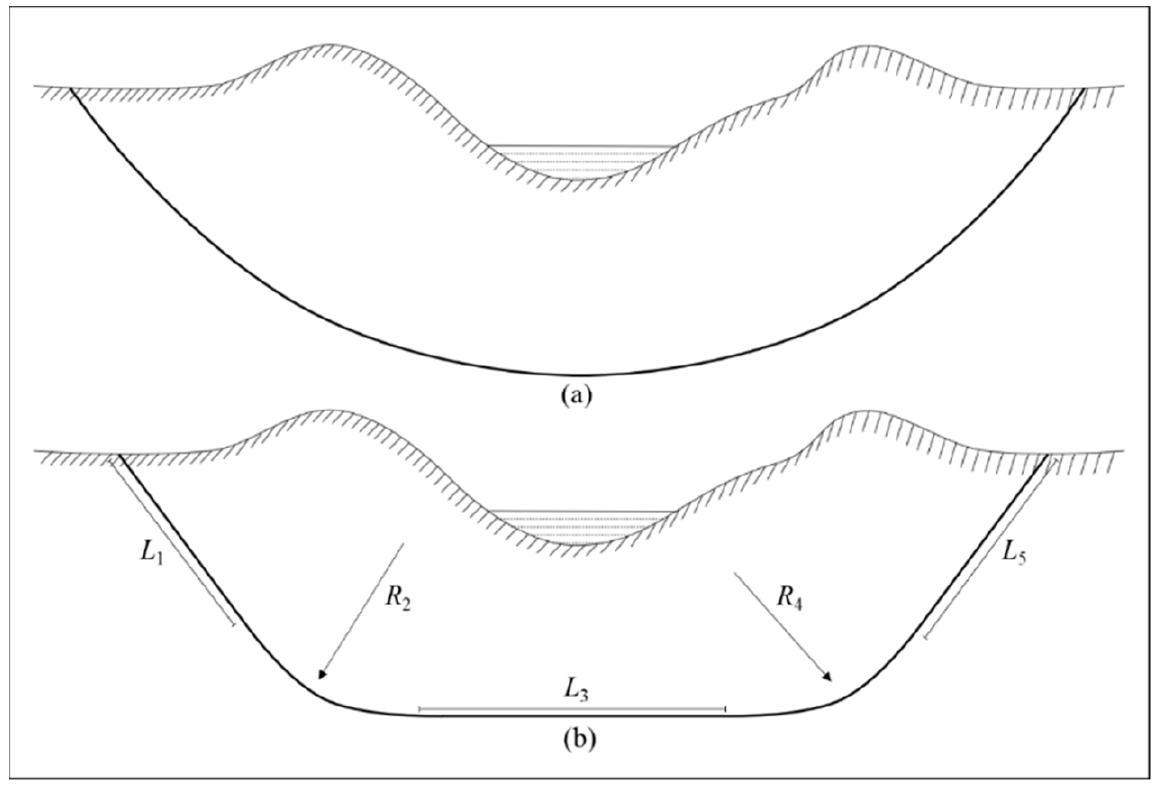
Figure 1. Catenary trajectory ( a ) and five-segment trajectory ( b ).